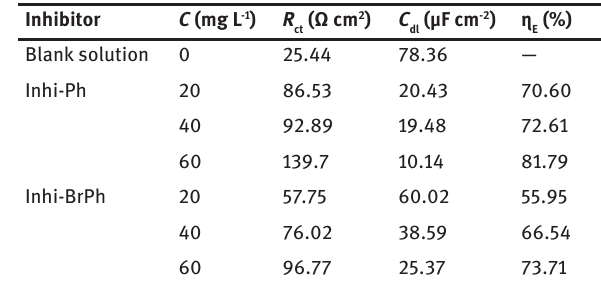
Table 5: The electrochemical parameters of impedance and the corresponding inhibition efficiency of Q235 steel in 1.0 M HCl with various concentration of Inhi-Ph and Inhi-BrPh at